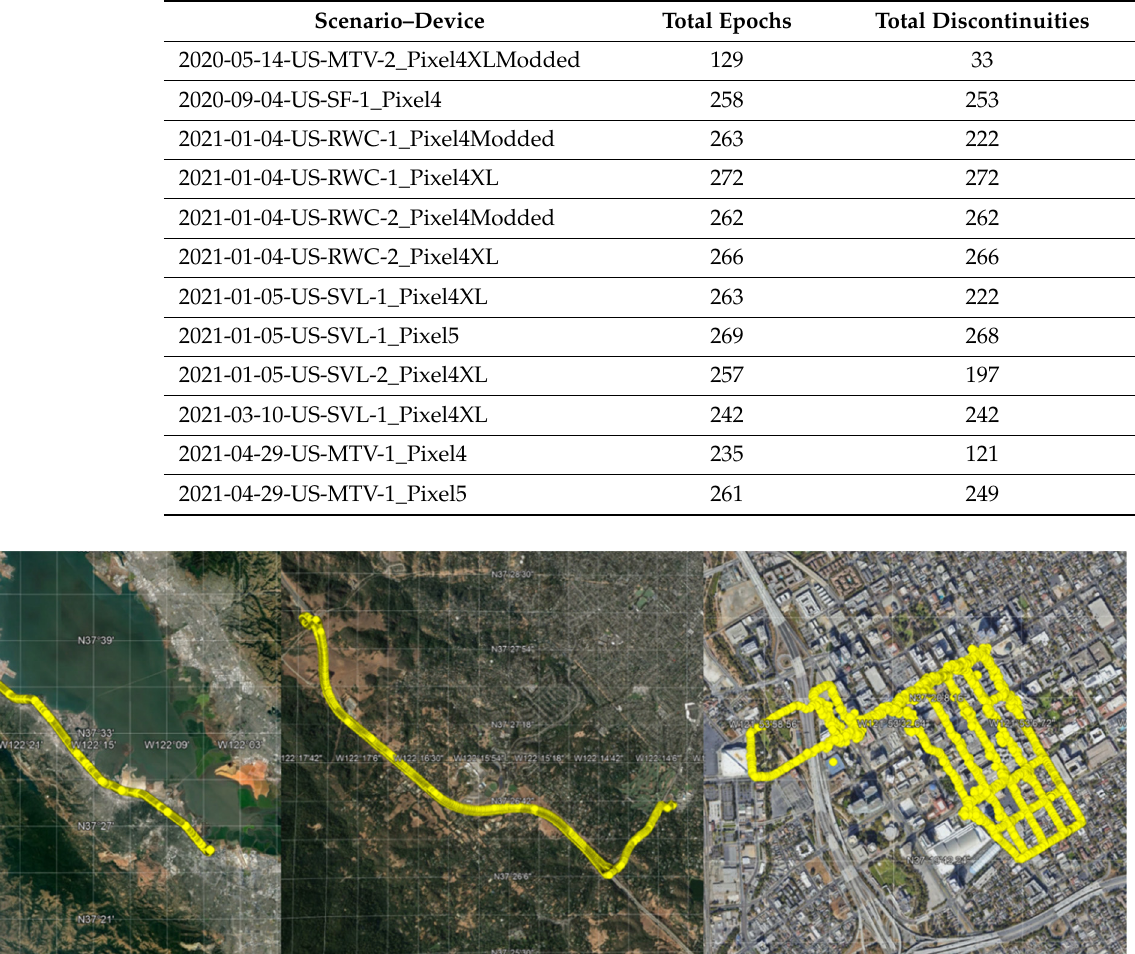
Table 2. Scenario and device combinations for the datasets that were excluded due to the presence of hardware clock discontinuities.